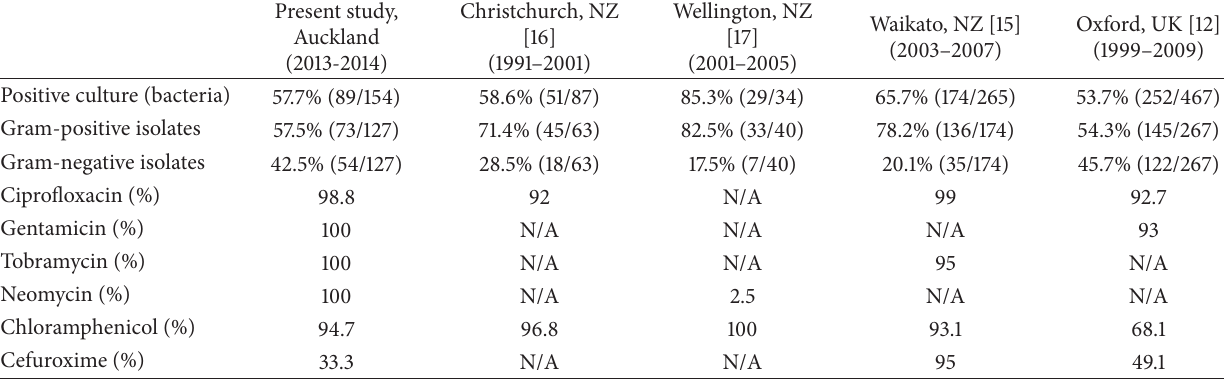
Table 4: Bacterial isolates and their sensitivity to commonly used antibiotics recorded in New Zealand and UK regions/cities. Present study,